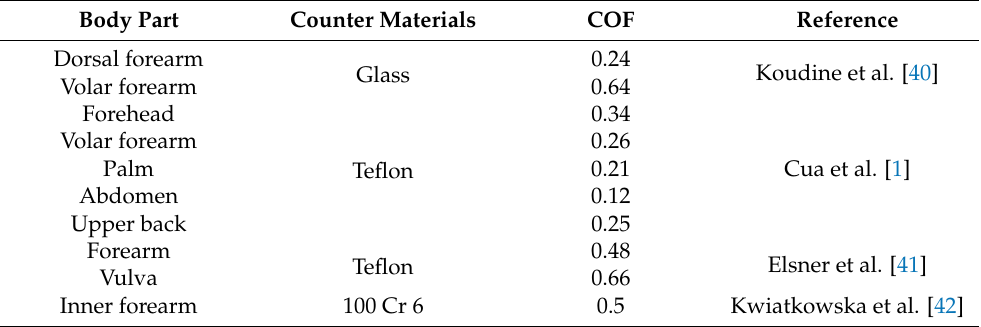
Table 1. COF on untreated normal skin of different body parts with respect to different counter materials. Body